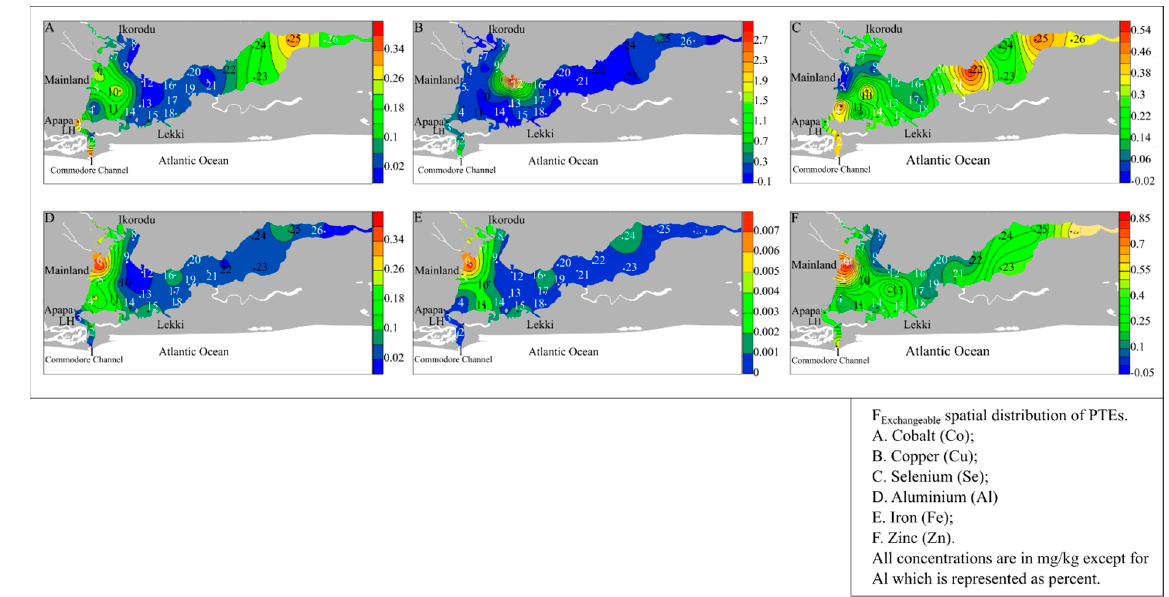
Figure A1. exchangeable fractions heat maps. Figure A1. Exchangeable fractions heat